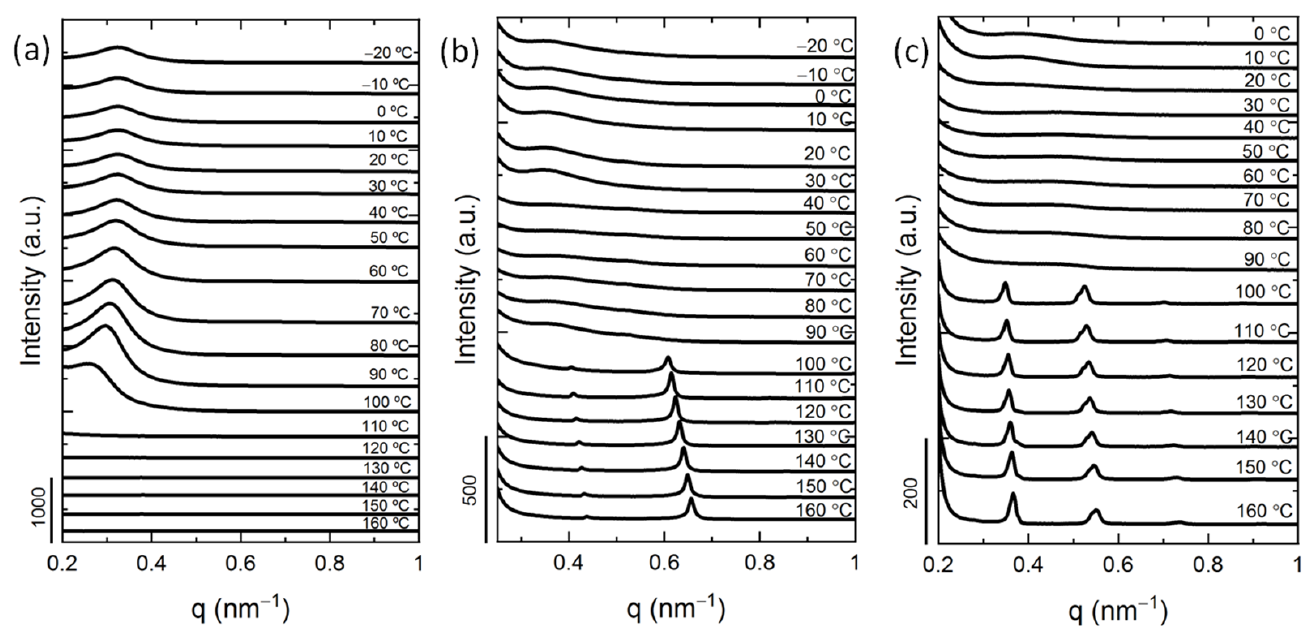
Figure 2. SAXS ramp down patterns at 20 °C/min for ( a ) PE 9.5 , ( b ) PE 529.5 -b- PEO 488.8 , and ( c ) PE 379.5 -b- PEO 348.8 -b- PCL 297.6 (T2) at the indicated temperatures. The diblock copolymer PE 529.5 -b- PEO 488.81 (Figure 2b) and the triblock terpolymer PE 379.5 -b- PEO 348.8 -b- PCL 297.6 (T2) (Figure 2c) are phase segregated in the melt, with possible